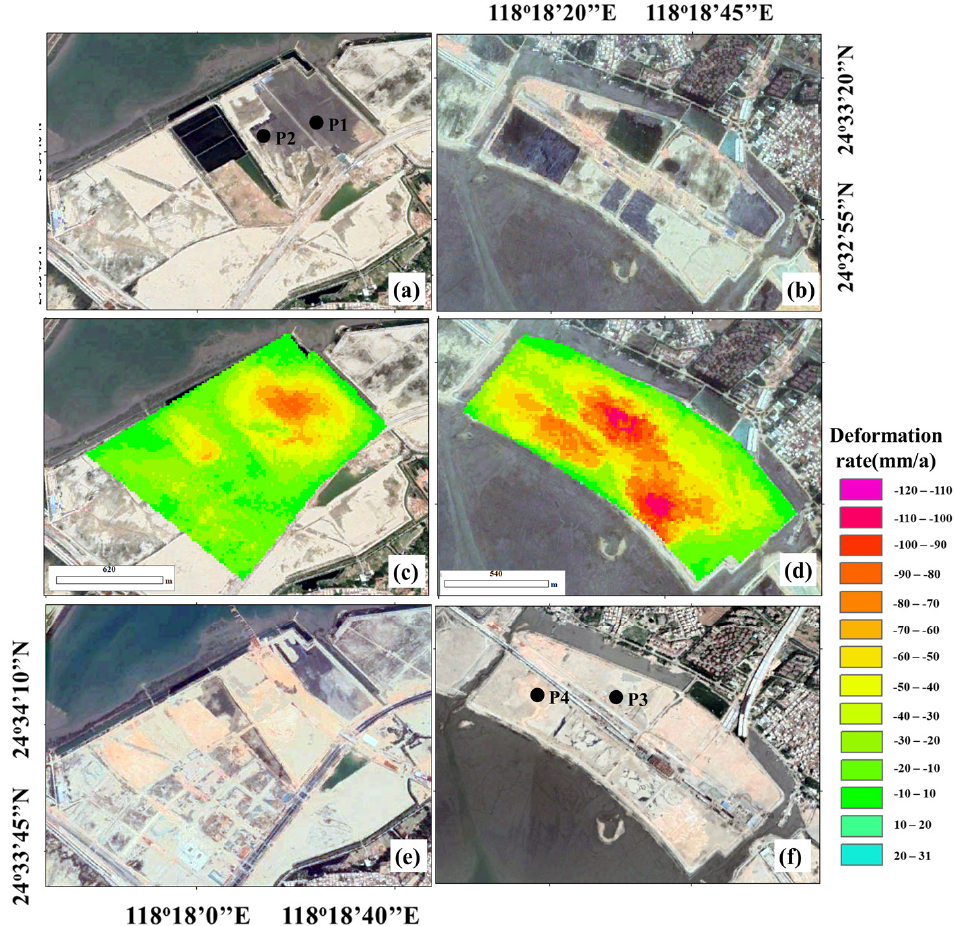
Figure 13. The vertical deformation rate maps and optical remote sensing images of regions A and B in Figure 2c. Remote sensing image acquired on ( a ) 18 June 2019; ( b ) 26 July 2019; ( e ) 30 April 2020; and ( f ) 26 October 2020. ( c , d ) are annual vertical deformation rate maps.